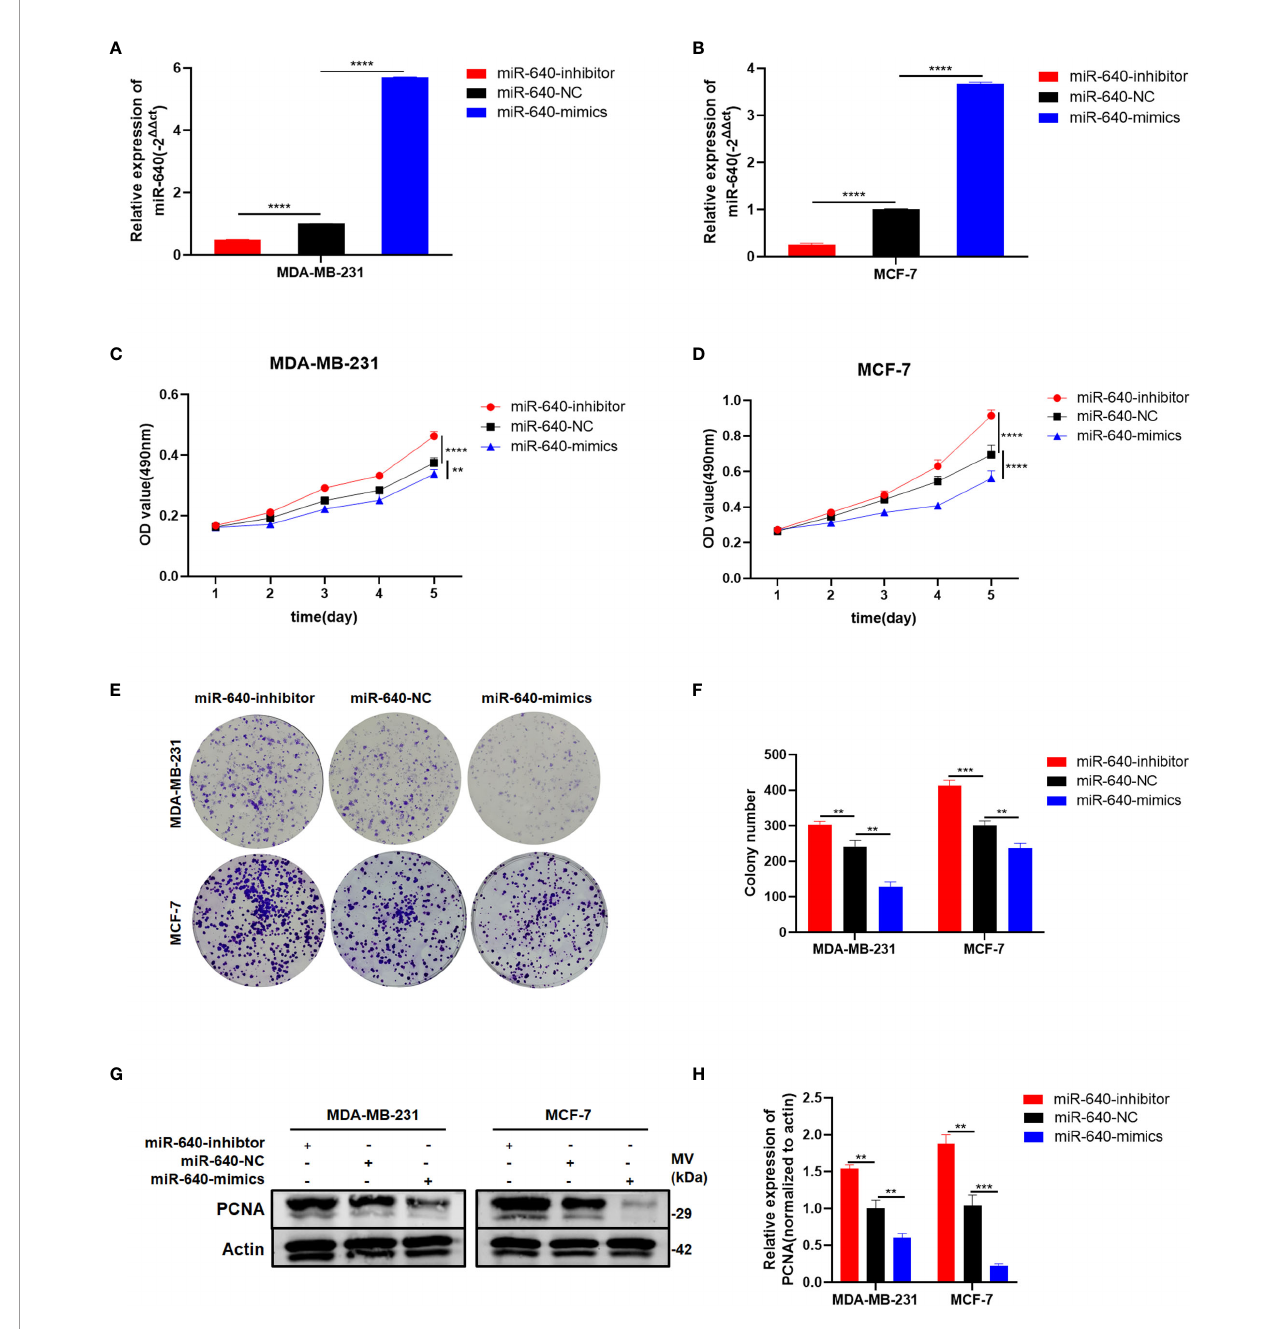
FIGURE 2 | MiR-640 suppressed cell proliferation of BC cells. (A, B) Expression of miR-640 was con fi rmed by RT-qPCR in MDA-MB-231 and MCF-7 cells. (C, D) Effect of miR-640 on proliferation in MDA-MB-231 and MCF-7 cells by MTT assay. (E, F) Effect of miR-640 on proliferation in MDA-MB-231 and MCF-7 cells by colony formation assay. (G, H) Effect of miR-640 on proliferation in MDA-MB-231 and MCF-7 cells by western blotting. **p < 0.01; ***p < 0.001; ****p <